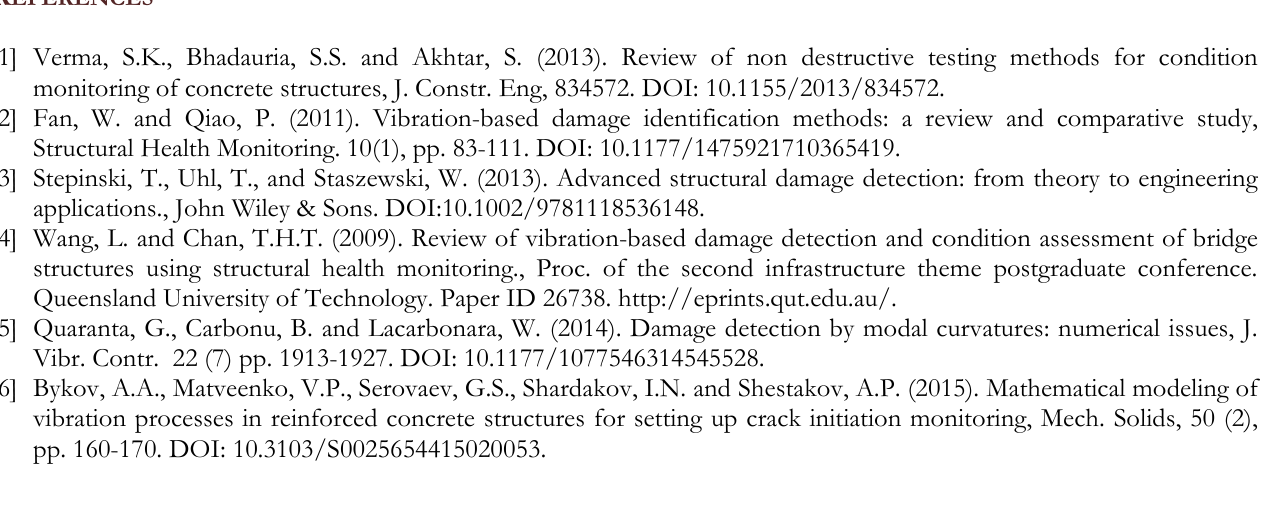
K a a at different stages of / 0 k